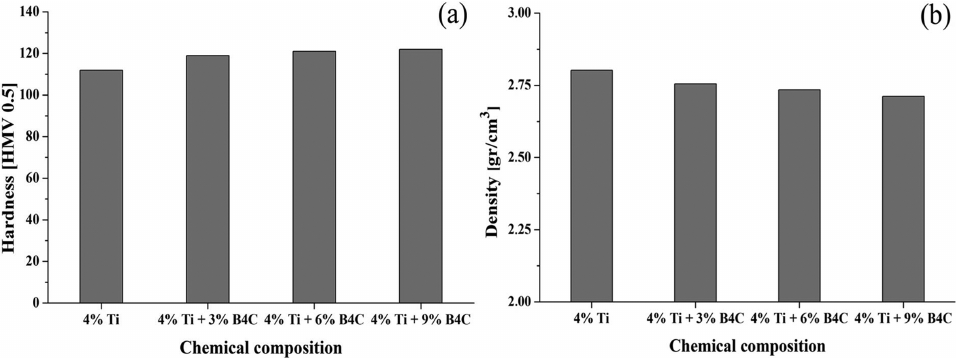
Figure 3: Hardness (a) and density (b) changes in the hybrid composites produced using the powder metallurgy